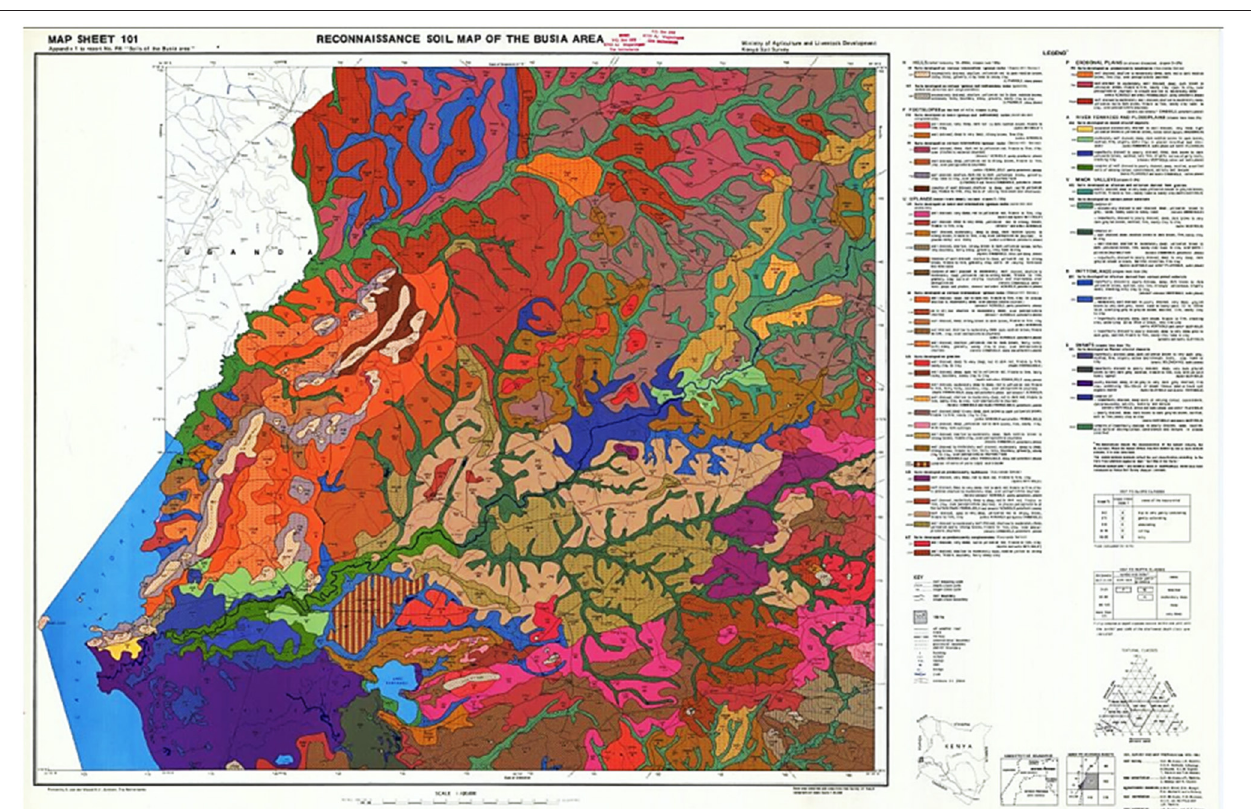
land types were further subdivided according to the underlying parent material on which the soils were developed, described as either the stratigraphy or underlying rocks such as dolerites, granites, etc. At the third level the map units were broken down and described based on important soil profile characteristics including drainage conditions, depth, color, consistency, texture, etc. (42). This was then followed between brackets (dominant